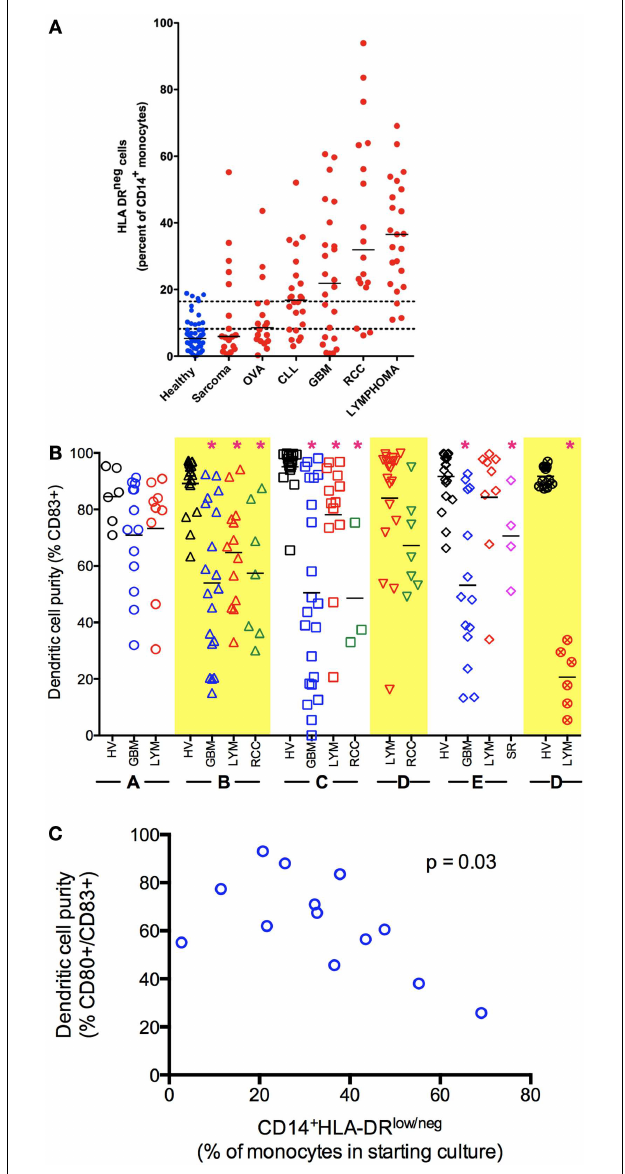
FIGURE 1 | Monocyte and dendritic cell defects in cancer . (A) Cancer patients have an increased percentage of CD14 + HLA-DR lo/neg monocytes in circulation. Peripheral blood of healthy volunteers and cancer patients was analyzed by flow cytometry for immune phenotype. (B) Monocytes from cancer patients have decreased capacity to differentiate to mDC (CD83 + ) under a variety of stimulation conditions. Monocytes were selected from blood of healthy volunteers (HV) or cancer patients (GBM, glioblastoma multiforme LYM, B-cell lymphoma; RCC, renal cell carcinoma; SR, sarcoma) by CD14 + immunomagnetic beads and cultured under different methods as labeled in X axis. Method A, fast-DC (28); B, ex vivo media with 5days culture as described (29, 30); C, 5days culture in StemLine media and GM-CSF, maturation factorsTNF α and PGE2 added in the last 2days of culture; D, method C with IL-4 added for 5days of culture; E, method D with poly I:C added to maturation factors; F, method D with CpG used as maturation factor in place ofTNF- α (* p < 0.05). (C) Decreased generation of mDC correlates with increased percentage of CD14 + HLA-DR lo/neg in the monocytes selected for culture (Method